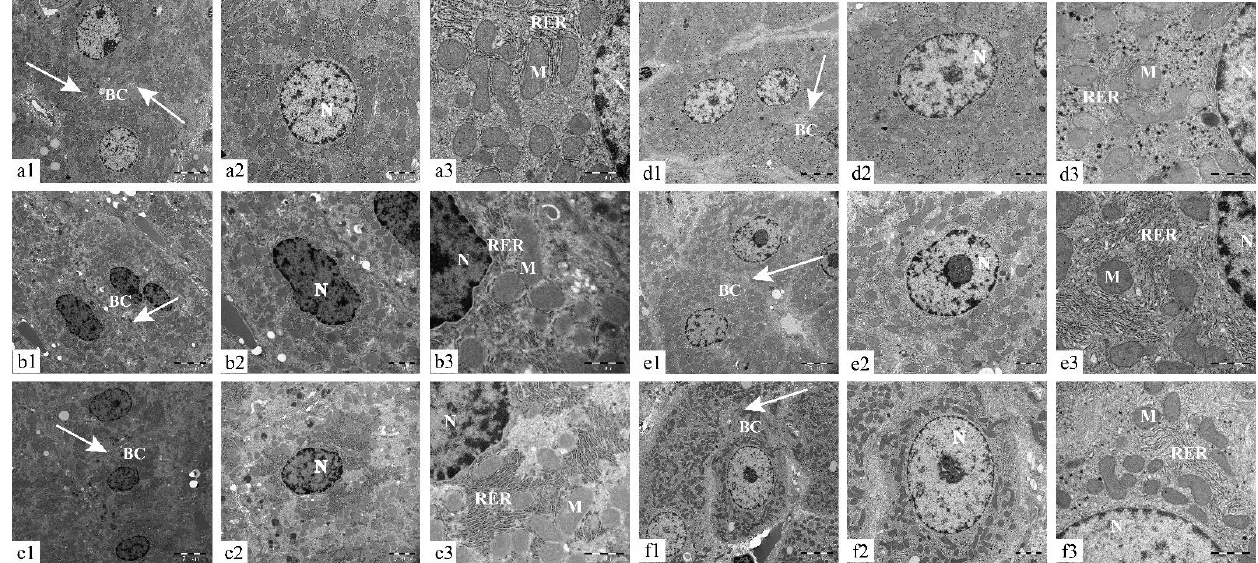
Figure 2. Effect of LRP on the ultrastructure of ACR-induced liver tissue in SD rats (1-5000×, 2- 10000×, 3-30000×), CON, ACR, LRP-L, LRP-M, LRP-H, LRP groups are expressed with a – f , respectively. Abbreviations: N-nucleus; RER- rough endoplasmic reticulum; M- mitochondria; BC- bile canaliculus; arrows, junctional complex. ACR, acrylamide; LRP-L, Lycium ruthenicum polyphenols in low dosage; LRP-M, Lycium ruthenicum polyphenols in medium dosage; LRP-H, Lycium ruthenicum polyphenols in high dosage; LRP, Lycium ruthenicum polyphenols control group.